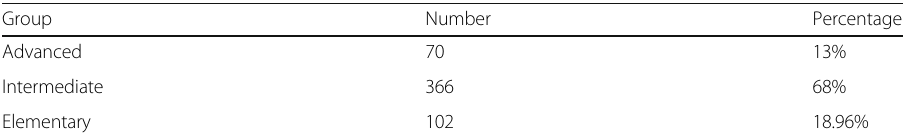
Table 2 The percentage of proficiency level of the participants Group Number Percentage Advanced 70 13% Intermediate 366 68% Elementary 102